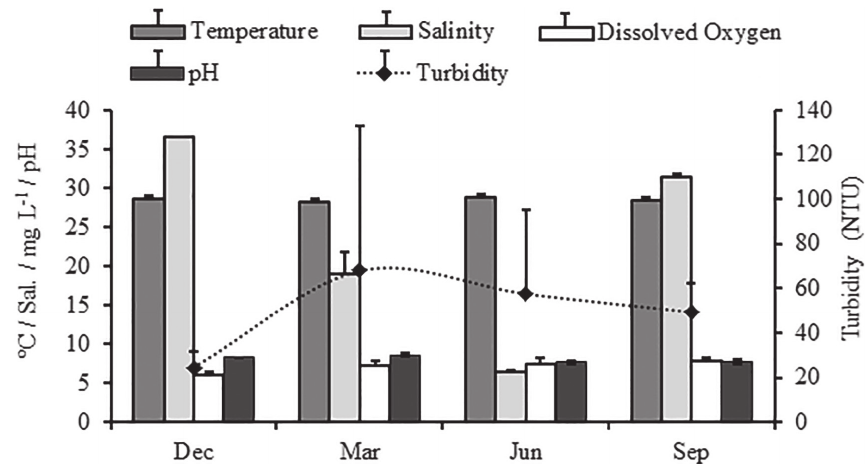
Figure 3 - Monthly average (±SD) of hydrological variables at Ajuruteua beach (Bragança, Pará) during the period of study: (A) turbidity (NTU), temperature (°C) and salinity; dissolved oxygen (mg L -1 ) and pH. vertical axes are plotted with different scales. Only positive deviation appears for variables with negative